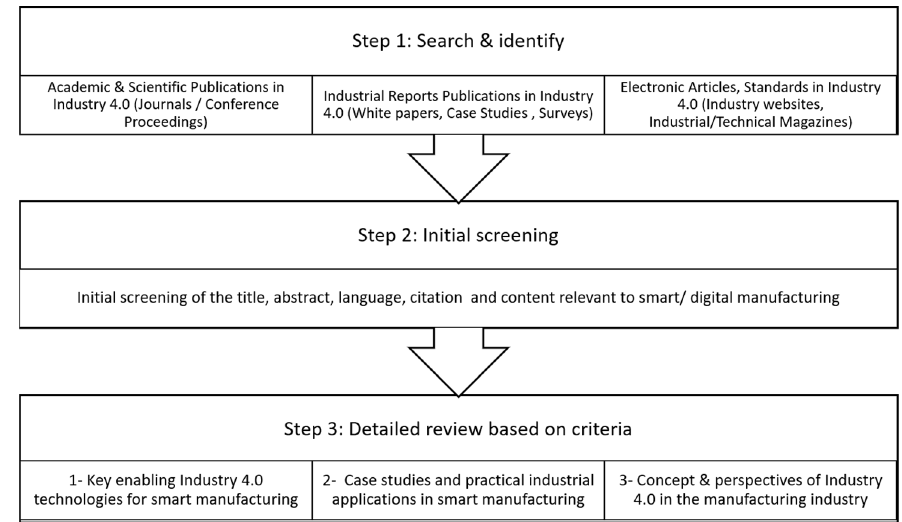
Figure 1. Schematic diagram for the conceptual modeling methodology.